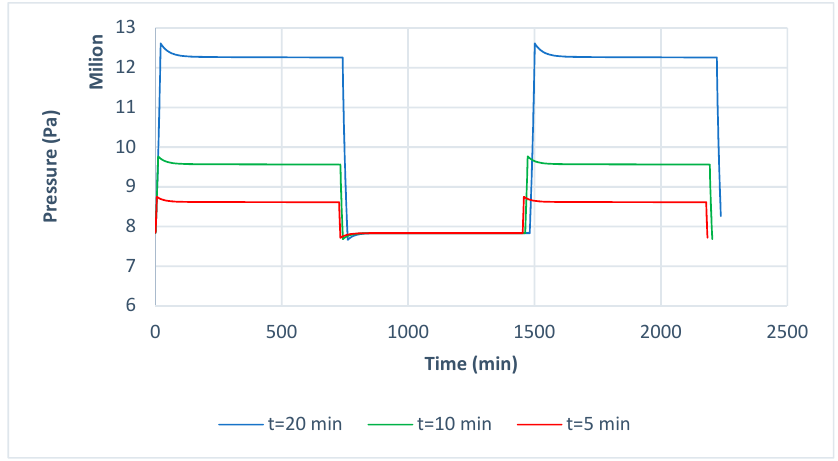
Table 9. Efficiency system for the first configuration varying the charging time.